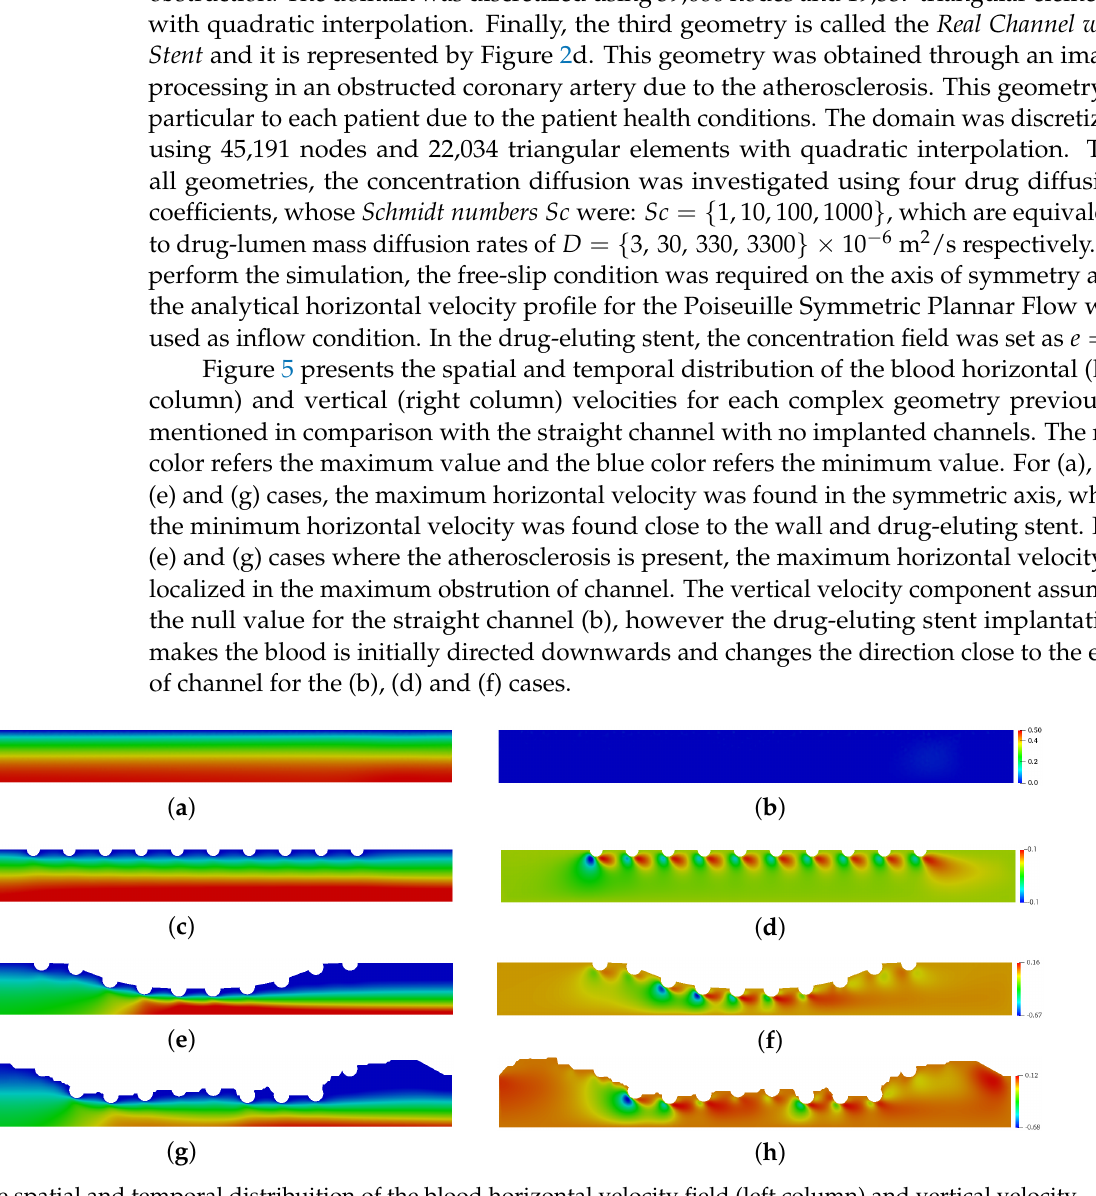
Figure 5. The spatial and temporal distribuition of the blood horizontal velocity field (left column) and vertical velocity field (right column) for the straight channel ( a , b ), the straight channel with drug-eluting stent ( c , d ), the curved channel ( e , f ) and the real channel ( g , h ) with drug-eluting stent for the Reynols number Re = 54.5, where it is calculated using the lumen radius of the coronary artery R = 0.0015 m, the viscosity of the blood µ = 0.0035 N · s/m 2 , the density ρ = 1060 kg/m 3 and the blood flow velocity in coronary artery u = 0.12